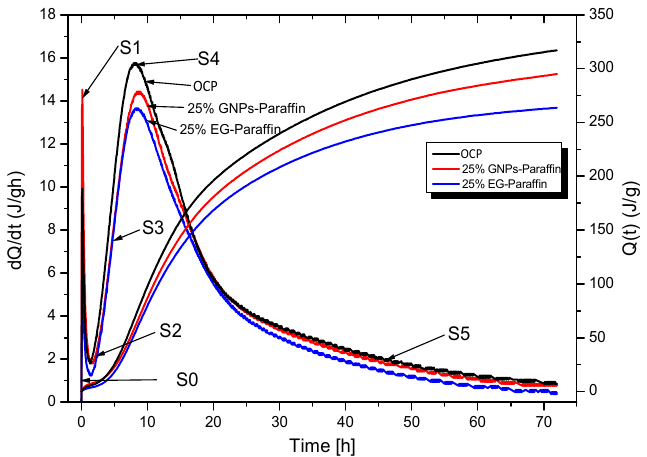
Figure 6. The effect of PCM addition on amount Q (t) of the heat of hydration and the releasing rate of the cement paste, with or without PCMs.